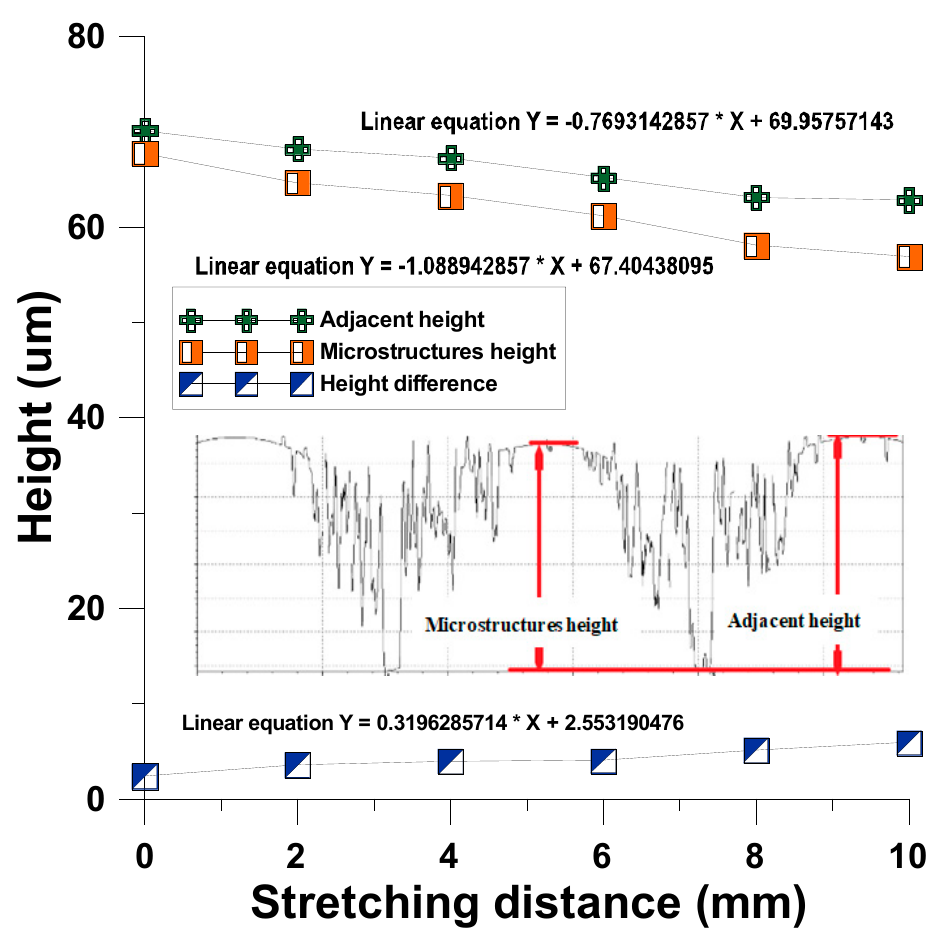
Figure 17. Influence of surface imprinting dynamically controlled uniaxial tensile on microstructure forming height.